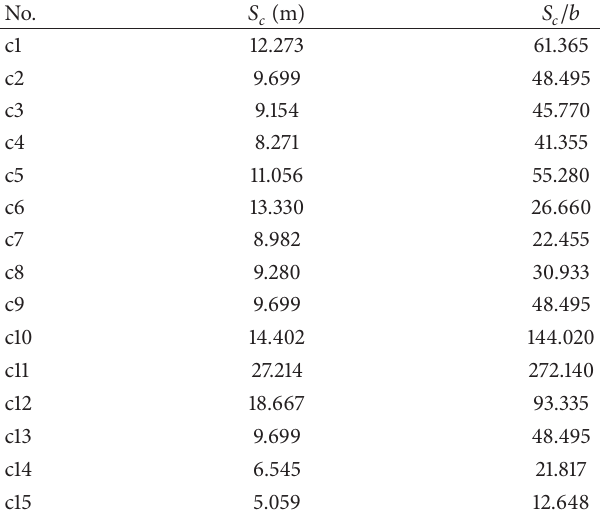
Table 3: Spacing thresholds of